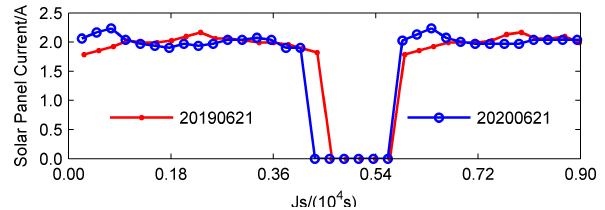
Figure 16. Current variations of the solar array